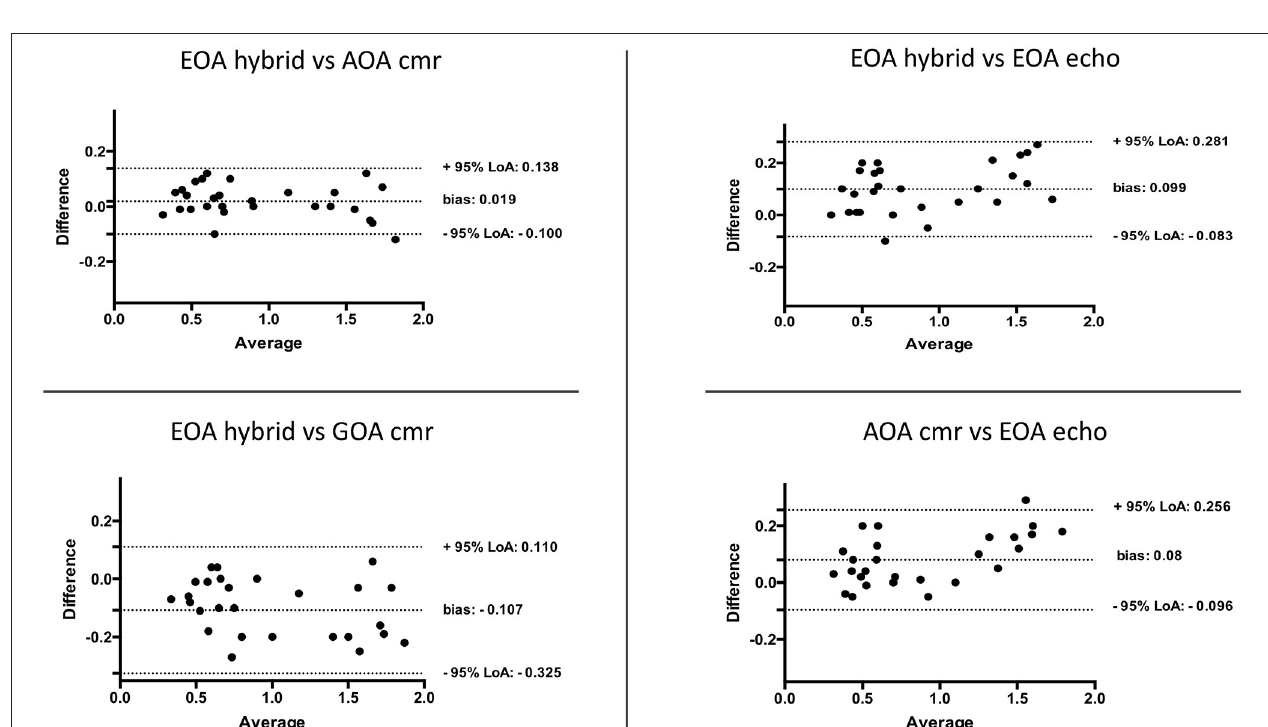
FIGURE 4 | Bland–Altman plots assessing the agreement between different methods for estimation of aortic valve area.